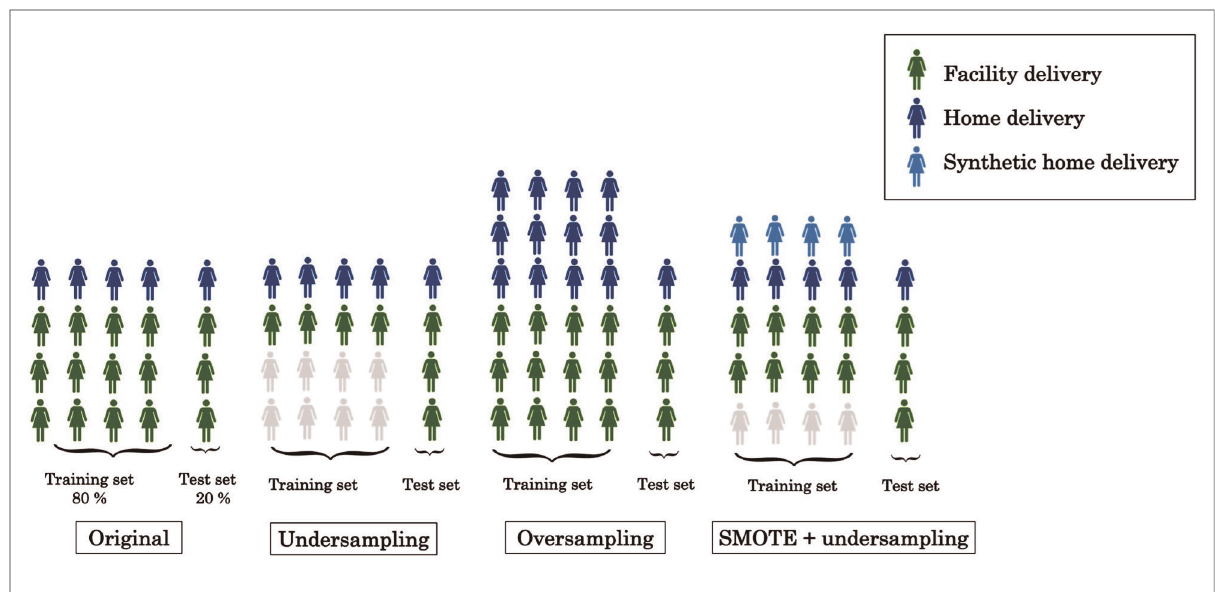
FIGURE 1 Illustration of training set undersampling, oversampling and SMOTE with